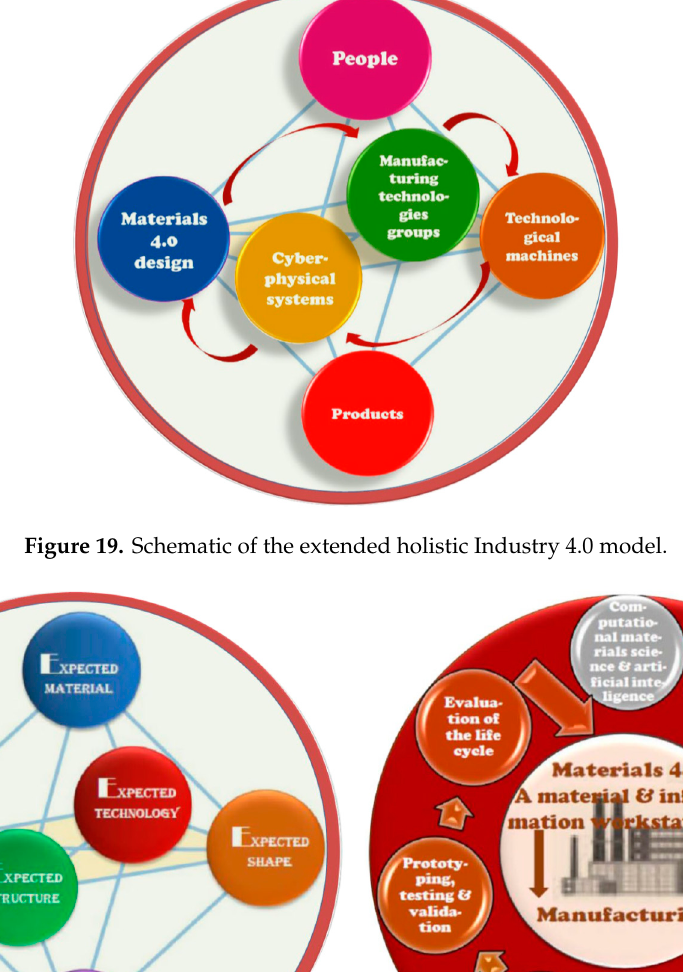
Figure 20. Material engineering paradigm ( a ) and a diagram of the Materials 4.0 methodology of material design as part of engineering design ( b ).